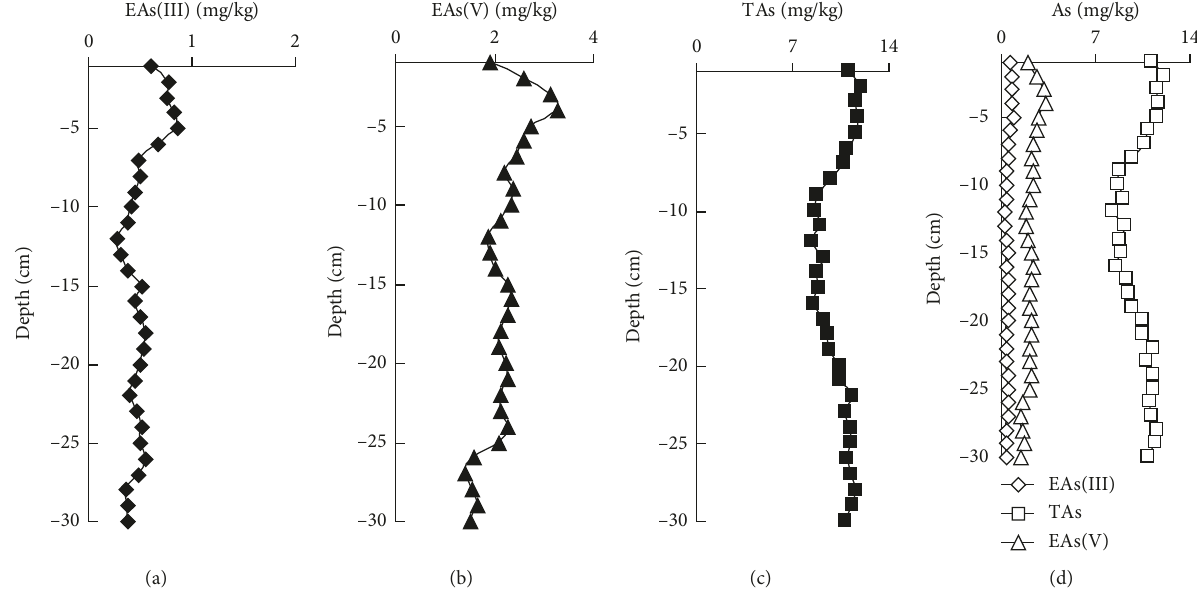
Figure 4: Profiles of EAs(III) (a), EAs(V) (b), and TAs (c) in sediments and their comparison